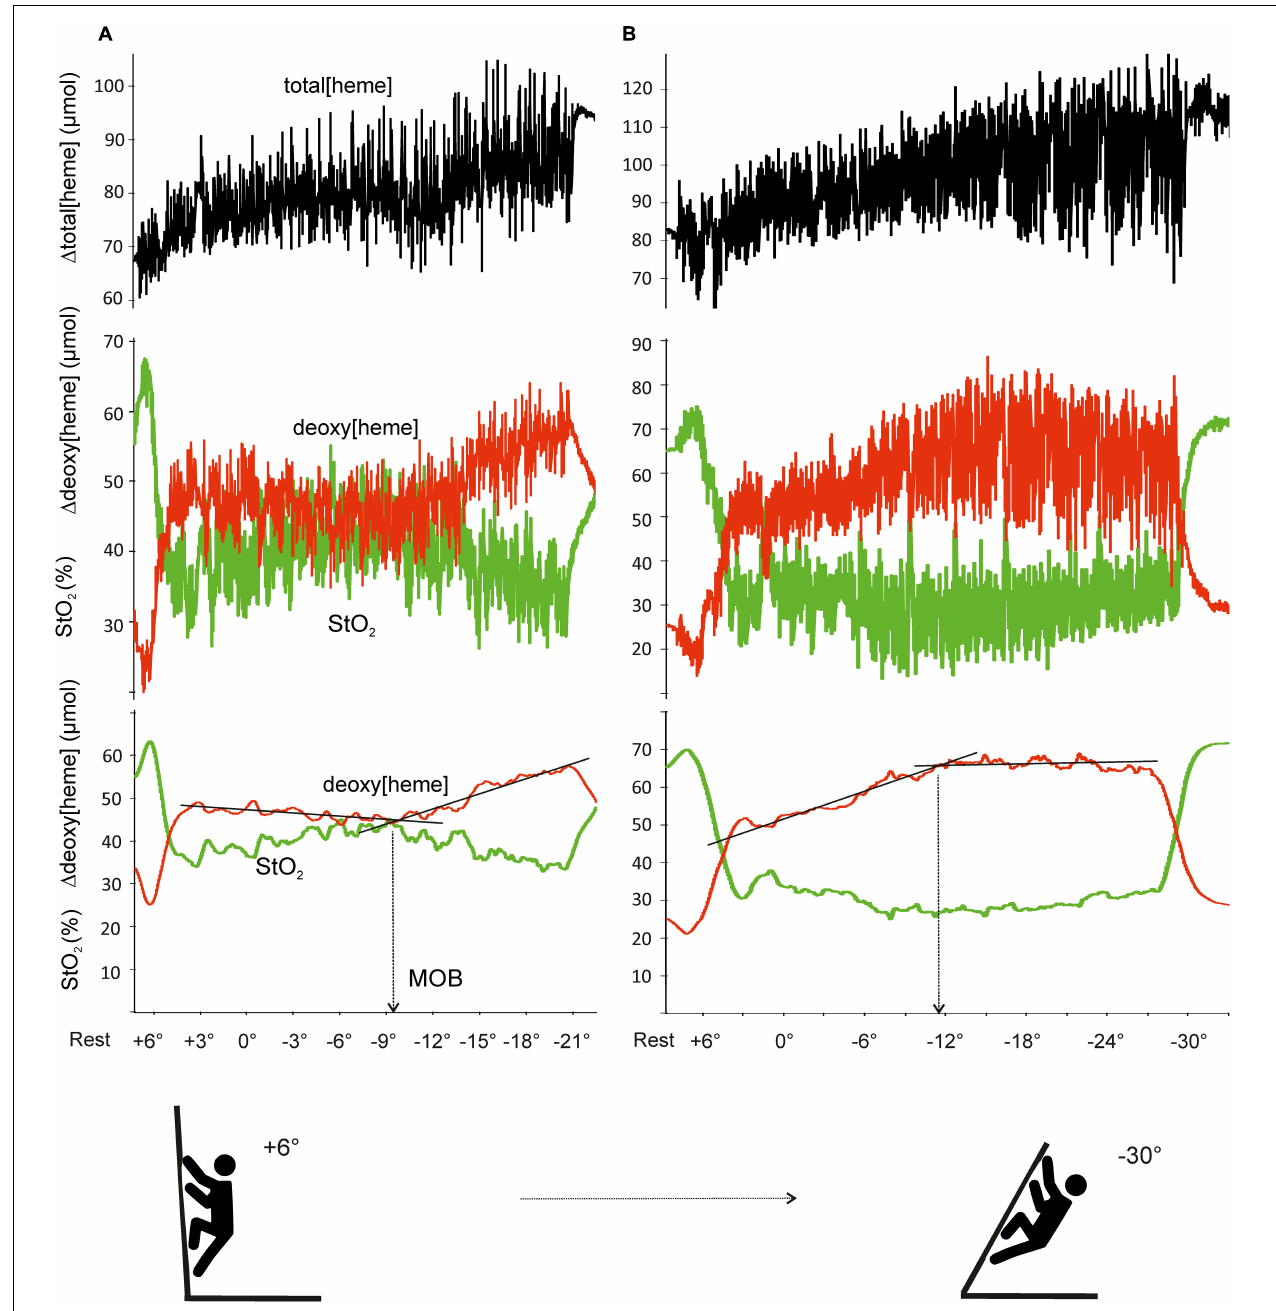
FIGURE 1 | Example of raw and averaged (10-s interval) signal for deoxy[heme], total[heme], and muscle tissue oxygen saturation (StO 2 ) during exhaustive climbing test with progressive increases in angle. MOB was detected as an inflection point of deoxy[heme] with progressive wall angle. Two typical responses represent sudden increase (A) and onset of a plateau (B) in (cid:49) deoxy[heme].